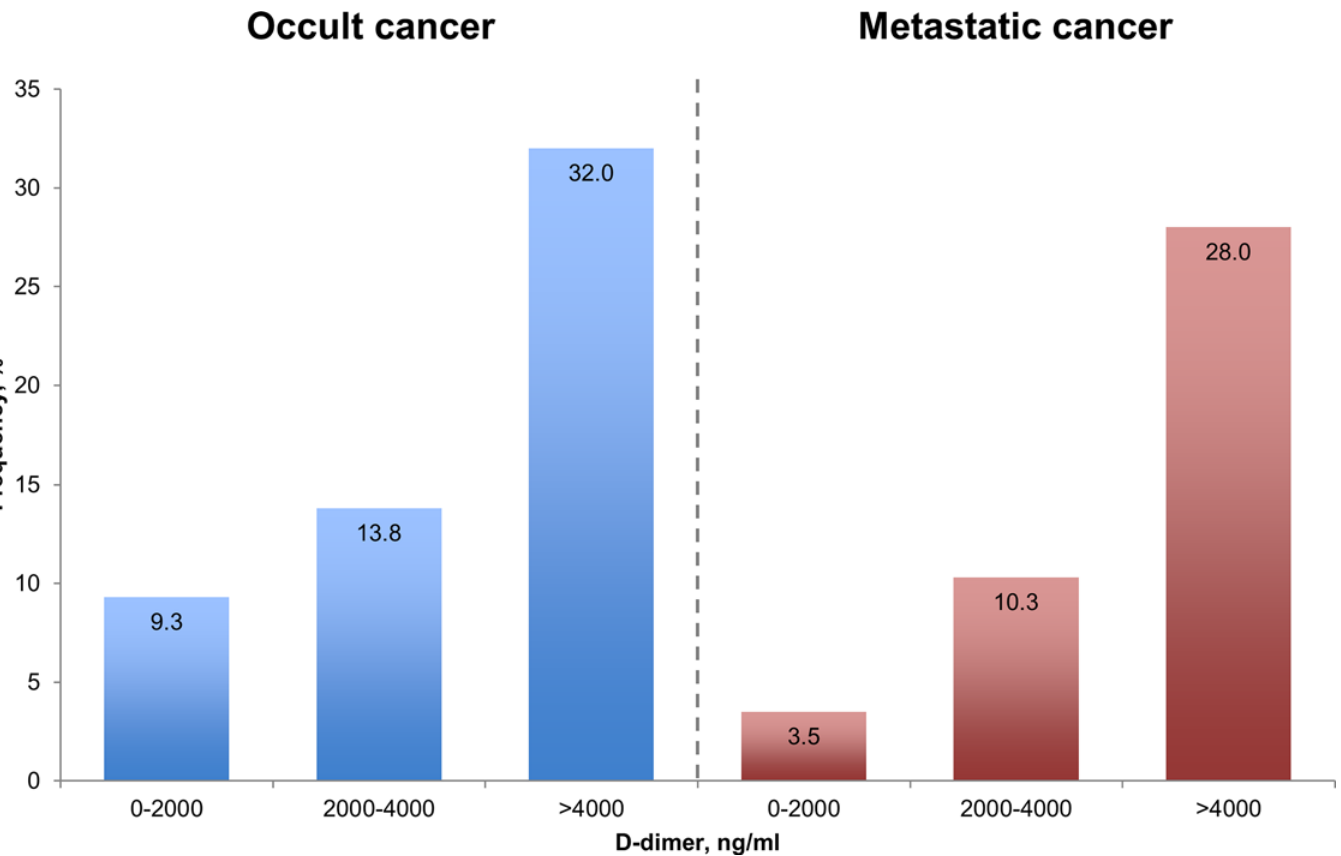
Fig 2. Incidence proportion of occult cancer and cancer with metastatic state according to quantitative level of